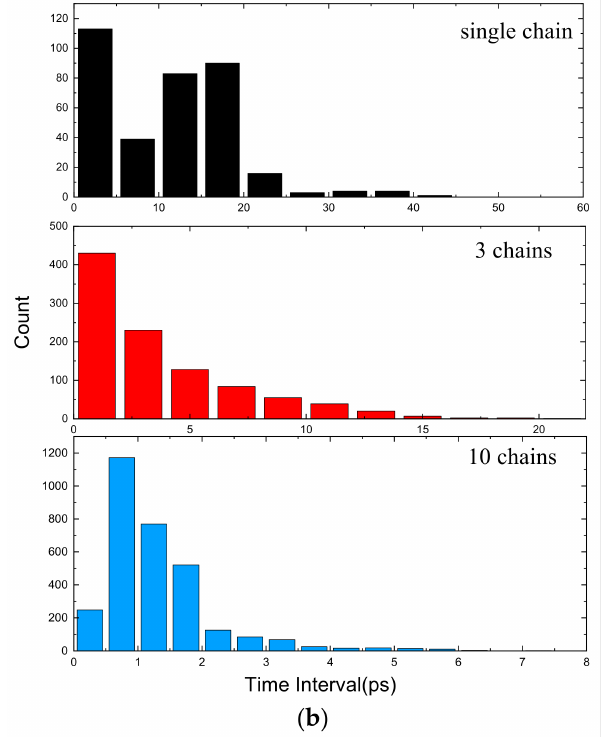
Figure 8. ( a ) Bin size with different chain numbers. ( b ) Histogram of bin size.